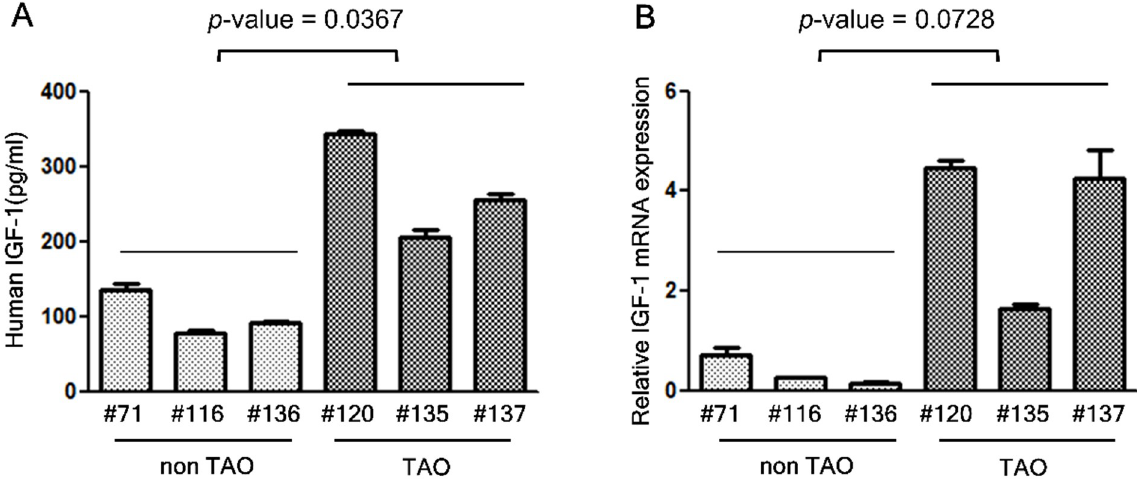
Fig 1. Orbital fibroblasts (OFs) from TAO patients secreted higher levels of IGF-1 and expressed higher levels of IGF-1 mRNA. (A) OFs from control individuals (#71, #116, #136) and patients with TAO (#120, #135, #137) were plated at a concentration of 2 x 10 5 cells/well in a 6-well plate. After 24 hours, the culture medium was analyzed for IGF-1 content using an ELISA kit (R&D Systems, Minneapolis, MN). (B) IGF- 1 mRNA expression was determined by quantitative real